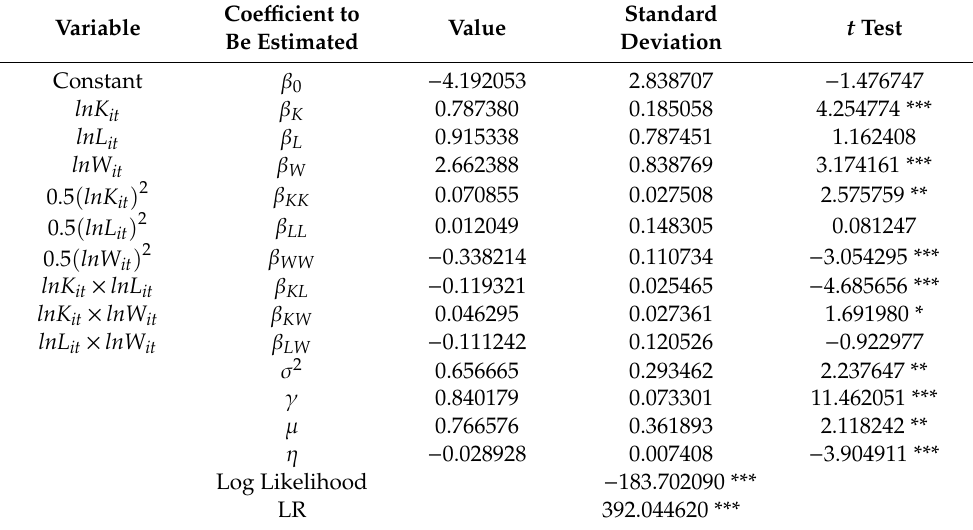
Table 2. Cross-provincial stochastic frontier analysis (2004–2018), the results of MLE. Coe ffi cient to Variable Be